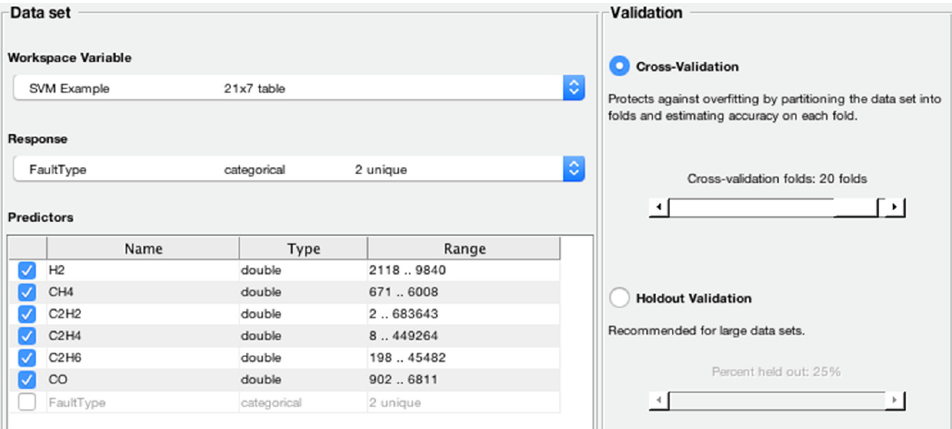
Figure 10. Confusion matrix for SVM 2 classifier.